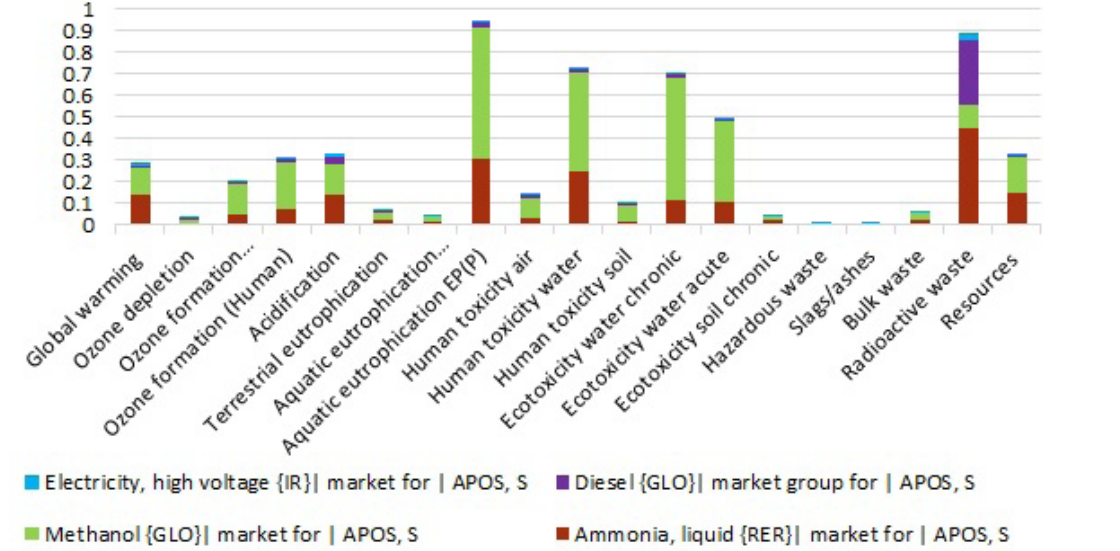
Figure 8. Results of applying normalization coefficients of the EDIP 2003 method in calculating impacts